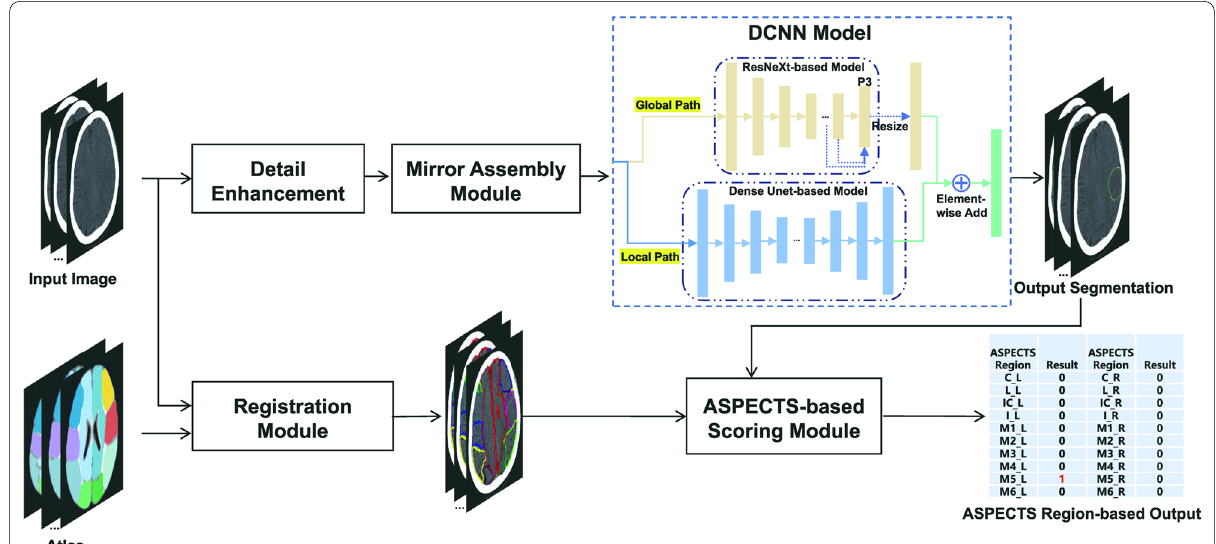
Fig. 2 Overview of the proposed DL model for lesion segmentation and ASPECTS scoring. This model included five key procedures of detail enhancement, mirror assembly module, DCNN model, linear registration and ASPECTS scoring module. The model generated two types of data: ischemic lesion segmentation and region-based